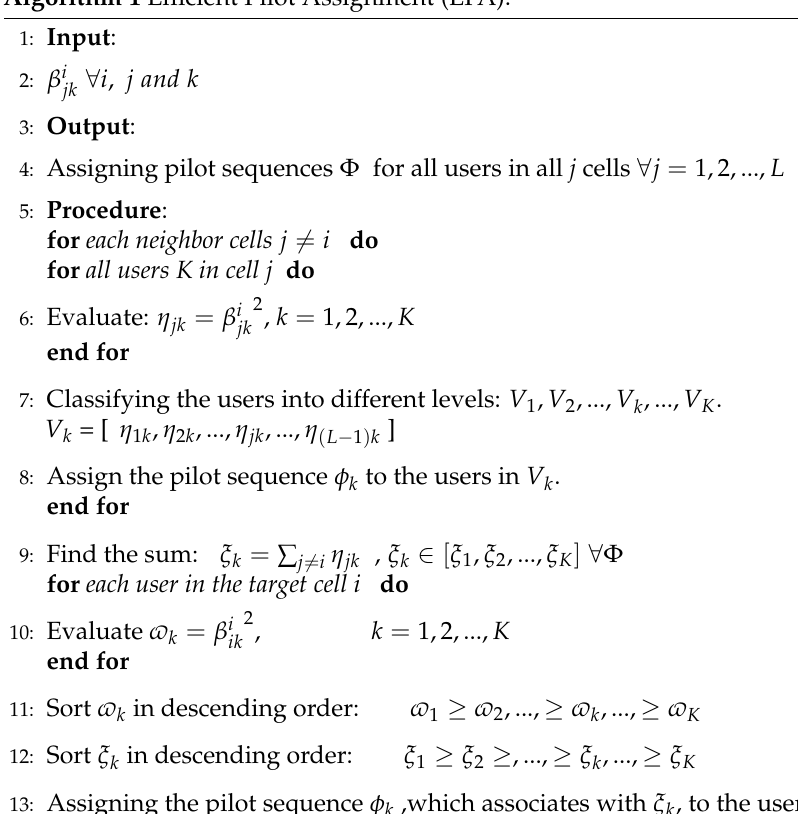
Algorithm 1 Efficient Pilot Assignment